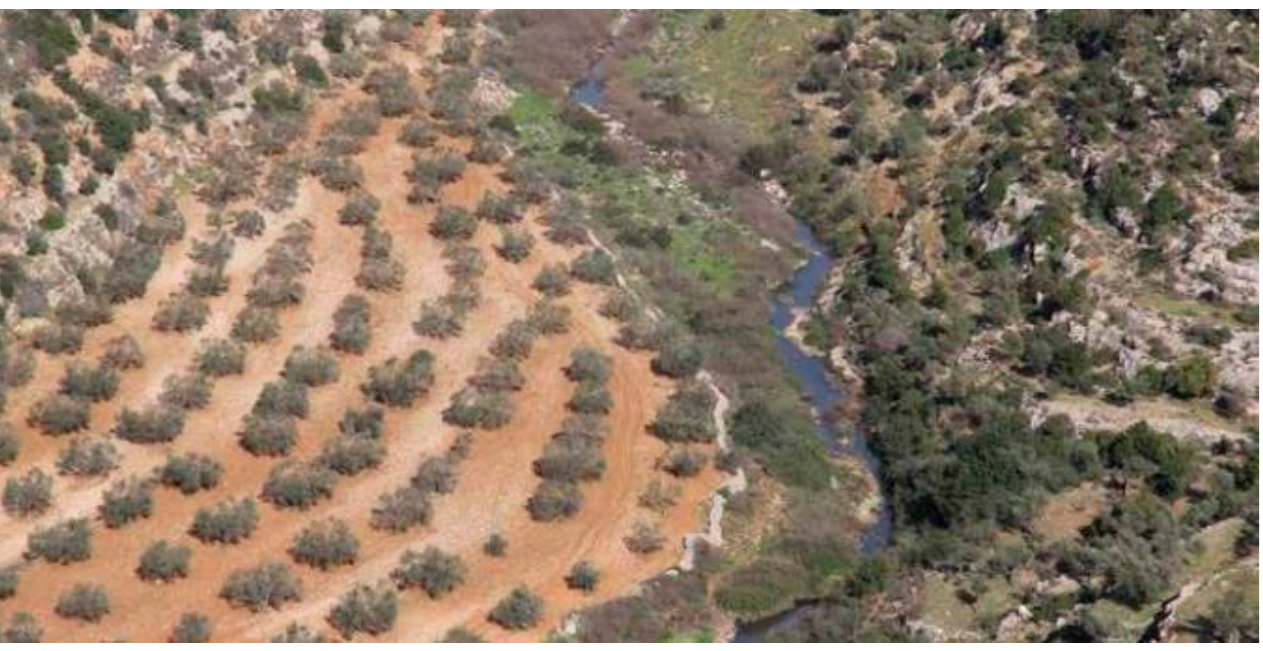
Figure 8. Flow of untreated sewage in part of the WZ PA. The picture also shows olive trees planted in the valley and small remaining natural areas on the steeper hills.